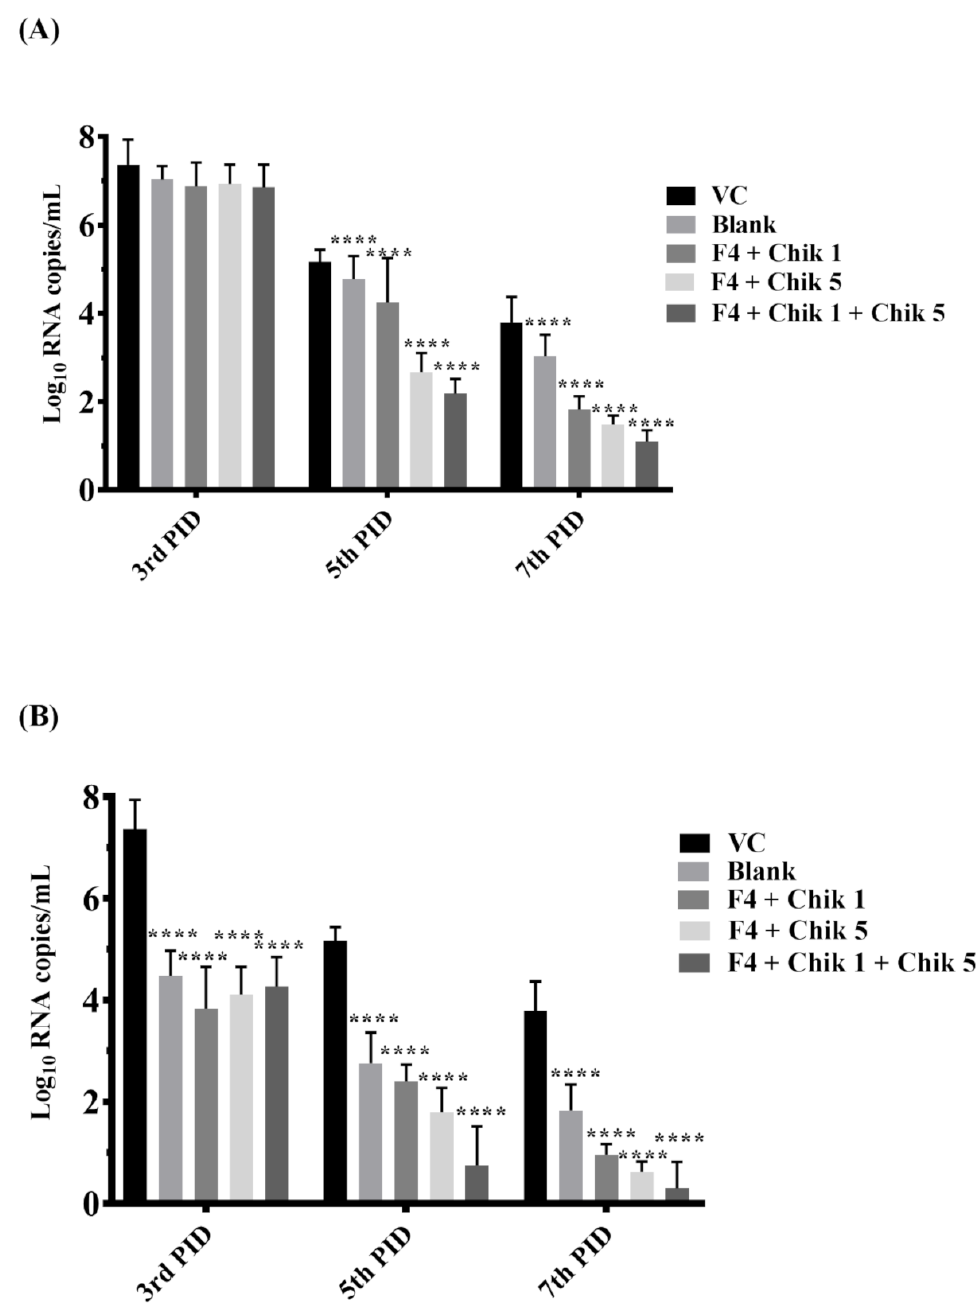
Figure 7. In vivo anti-CHIKV activity of siRNA-complexed SLN delivery system. The reduction in CHIKV copies/mL in ( A ) serum and ( B ) muscle tissue after treatment with the siRNA-loaded F4 delivery system. C57BL/6 mice (n = 9) were infected with CHIKV intramuscular route (100 µ L of 10 7 pfu/mL). After 72 h p.i. (3rd day), mice were treated with the siRNA-loaded F4 delivery system by intravenous route with different treatment combinations. Viral RNA copies were checked in serum and muscle tissue at different time intervals. CHIKV E3 RNA was quantitated using real-time RT-PCR. Values are given as LOG10 RNA copies/mL serum and LOG10 RNA copies/mg of tissue. **** p < 0.0001 VC, virus